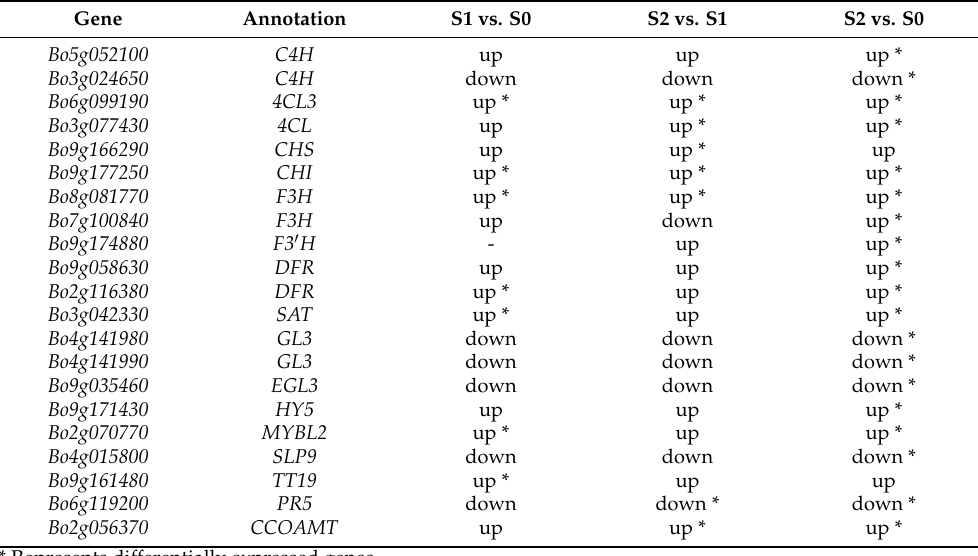
Table 2. Differently expressed genes related to anthocyanin biosynthesis at S1 vs. S0, S2 vs. S1 and S2 vs. S0.